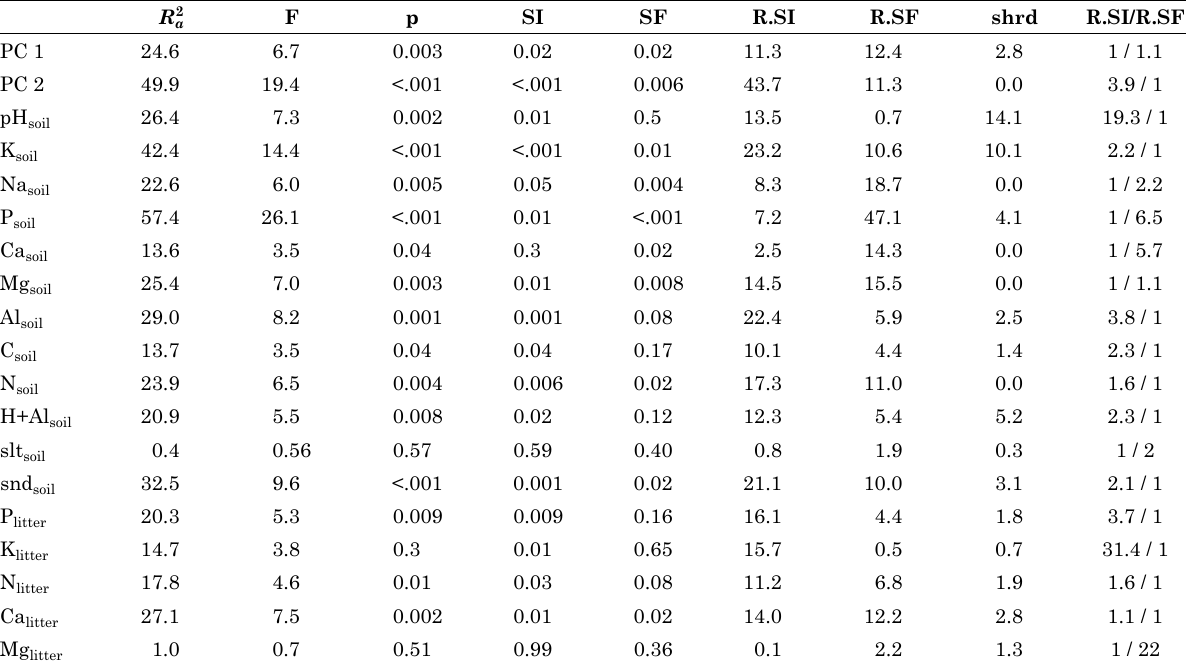
Table 5. Results obtained from the regressions and partial regressions carried out for each of the first two principal components (pC i ) of the principal Component analysis, and each soil and litter property. The table shows goodness of fit for all 19 models (R 2 ), their F values (F), and their significances (p). The significance of each of the 19 models for incident solar radiation (SI) and the spatial filters (SF) are also shown. in addition, it shows the percent of relative contributions of incident solar radiation (r.Si), spatial structure (r.Sf), and shared sunlight and spatial fraction (shrd) in explaining soil and litter variation on Marambaia island. ratios between the contributions of incident solar radiation and the spatial structure are also given (Si /